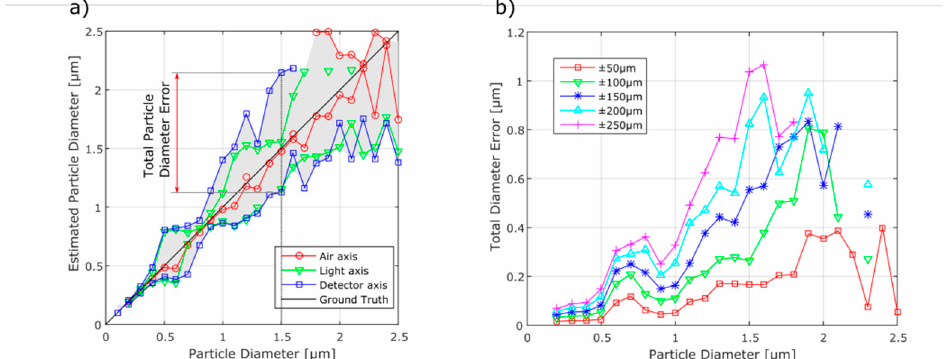
Figure 3. ( a ) Graph of sizing error with d min and d max diameter estimation for ±250 µm displacement in each of the axis. Here the 45° line indicates the ideal curve of zero sizing error. The gray area indicates the maximal error, obtained by the extremal error estimation of all three responses for each particle, here mostly dominated by the displacement in the detector axis. This way, we obtain a total particle diameter error for each particle, as indicated for 1.5µm particle. ( b ) Graph of total particle diameter error as a function of particle size for different ranges of displacements ranging from ±50 µm to ±250